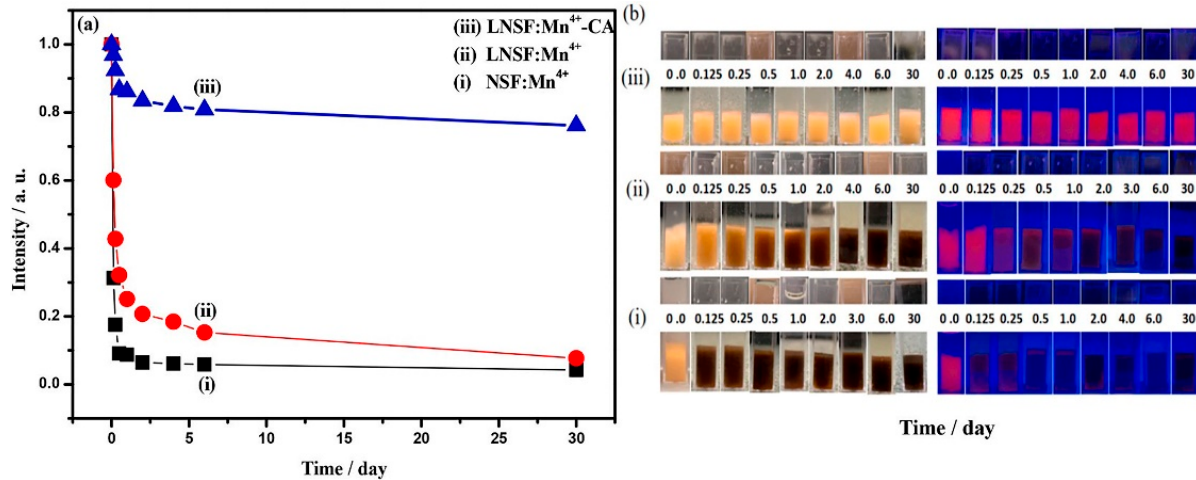
Figure 16. ( a ) Comprehensive PL intensity; ( b ) photographs in natural light and under 365 nm UV light. (i) NSF: Mn 4+ , (ii) LNSF: Mn 4+ , and (iii) water resistance of LNSF: Mn 4+ -CA soaked in deionized water for 30 days. (Reprinted from Ref [57]. Copyright from Elsevier, 2022).